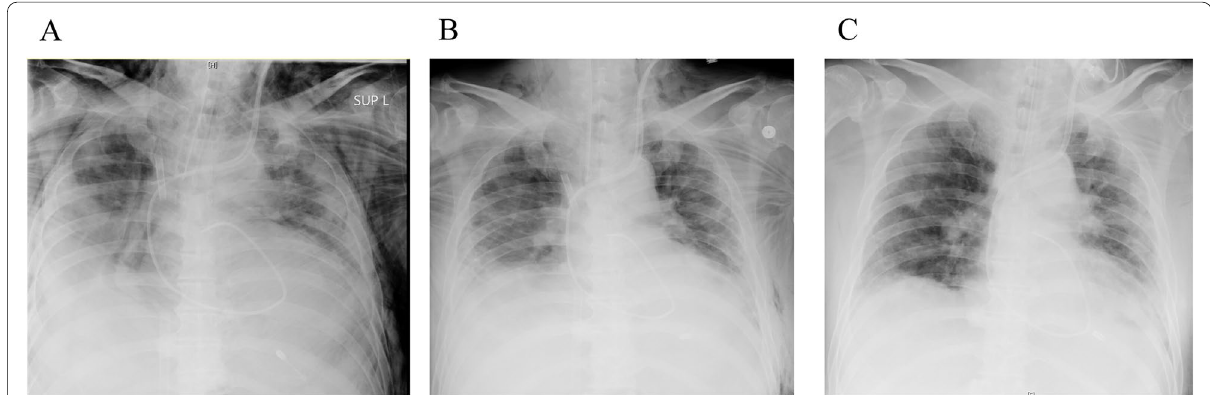
Fig. 2 Chest X-ray of the patient. A On admission. B Fourth day post-ECMO cannulation. C Post-ECMO decannulation. These X-rays showed that extensive pneumomediastinum/subcutaneous emphysema gradually